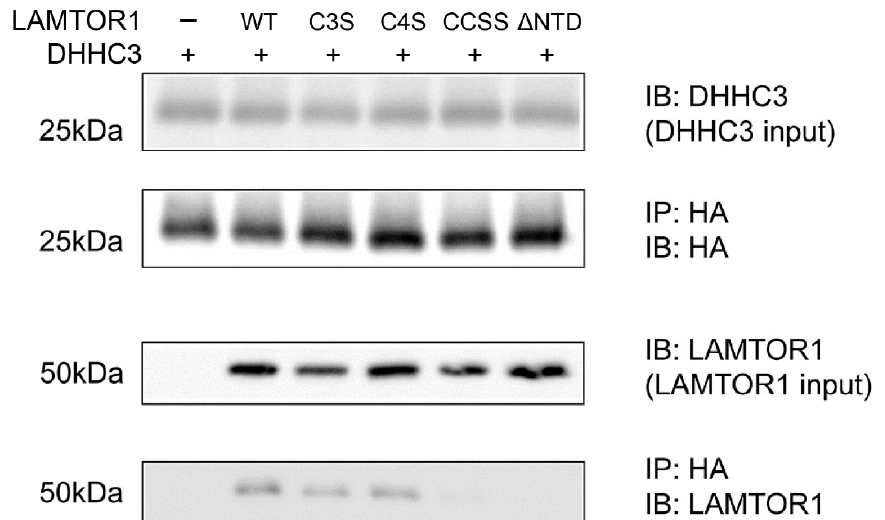
Figure 3. Pull-down assay and validation of interactions between hDHHC3 and LAMTOR1 by Western blot. hDHHC3s and LAMTOR1 were co-transfected into HEK 293T cells, subjected to co- immunoprecipitation (Co-IP) and analyzed by Western blot. The input proteins were analyzed by immunoblotting (IB) using total cell extracts (top and third panels). Co-immunoprecipitated hDHHC3 proteins using anti-HA affinity resins were probed with anti-HA (second panel) and anti-LAMTOR1 antibody (bottom panel),